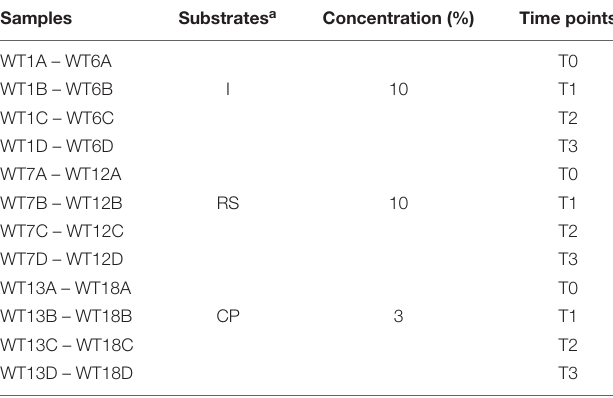
TABLE 1 | Fecal samples from rats collected at the different time points. Samples